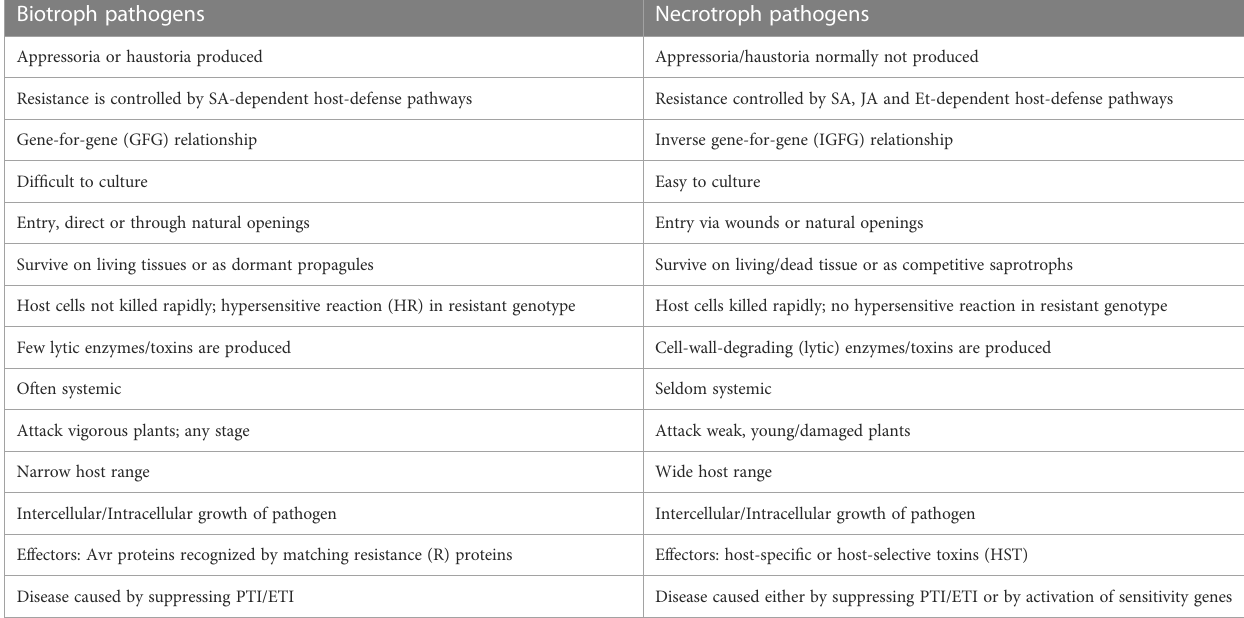
TABLE 1 A comparison of characteristics of biotrophs and necrotrophs (based on the link http://www.davidmoore.org.uk/ 21st_Century_Guidebook_to_Fungi_PLATINUM/Ch14_10.htm). Biotroph pathogens